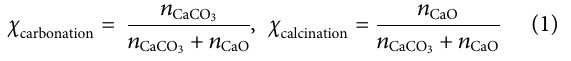
Frontiers in Energy Research |